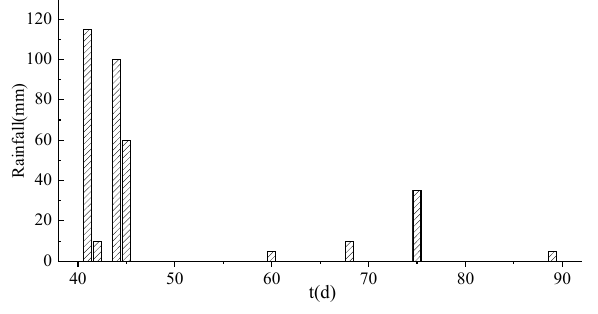
Figure 5. Rainfall statistics in the slope area.